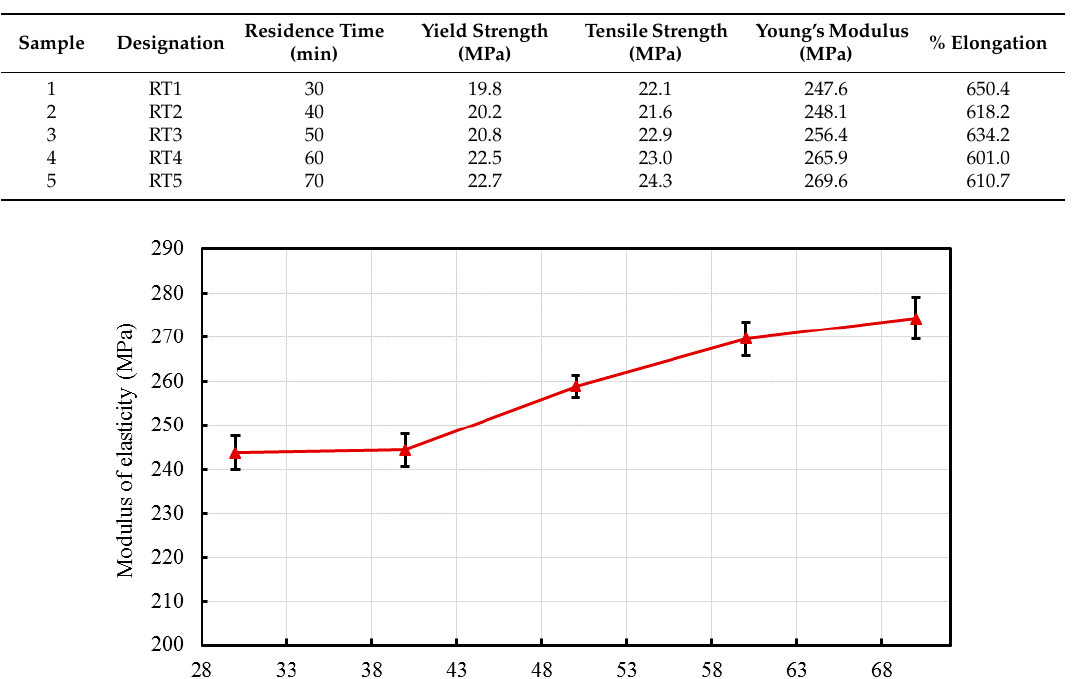
Table 2. Summary of the results obtained from the mechanical tests performed on the injection-molded nanocomposites with varying residence times.